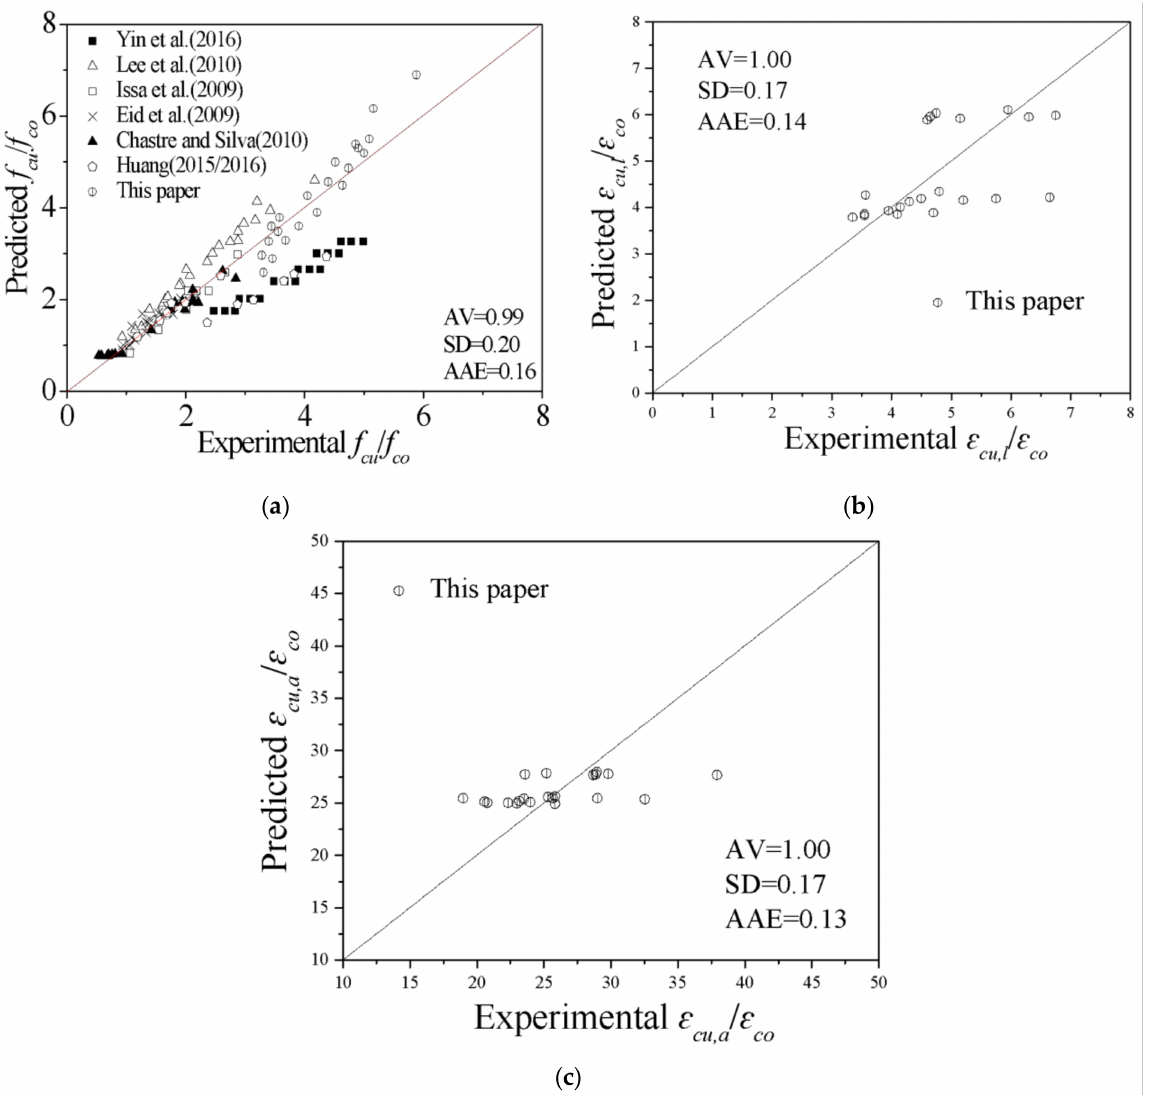
Figure 14. Evaluation of the ultimate point models. ( a ) Ultimate stress. ( b ) Local ultimate strain. ( c ) Overall ultimate